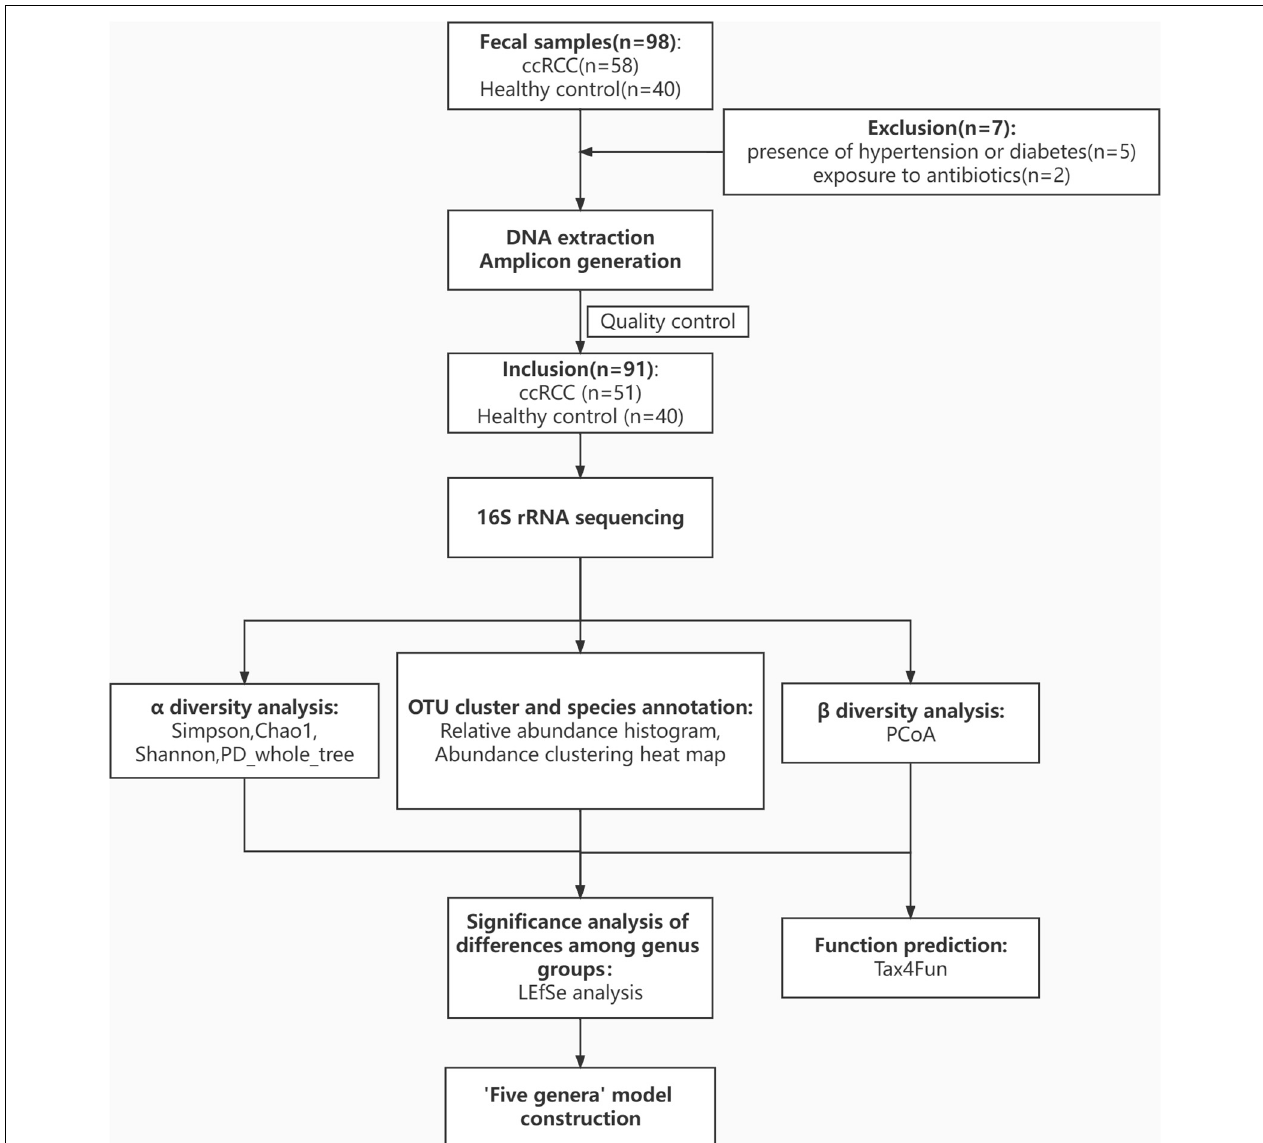
FIGURE 1 | Study design and flow diagram. In total, 98 fecal samples from Renji Hospital were prospectively collected. After excluding 5 patients for the presence of hypertension or diabetes and 2 patients for exposure to antibiotics, 51 patients with ccRCC, and 40 healthy controls were included and their gut microbiota was characterized. ccRCC, clear cell renal cell carcinoma; HC, healthy